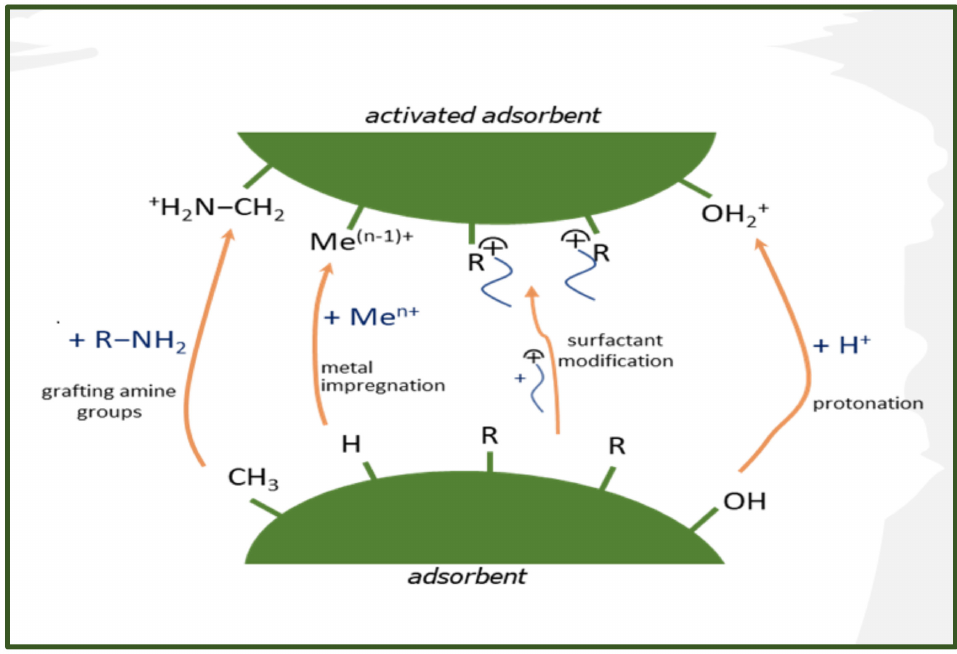
Figure 4. Schematic illustration of surface functionalization of